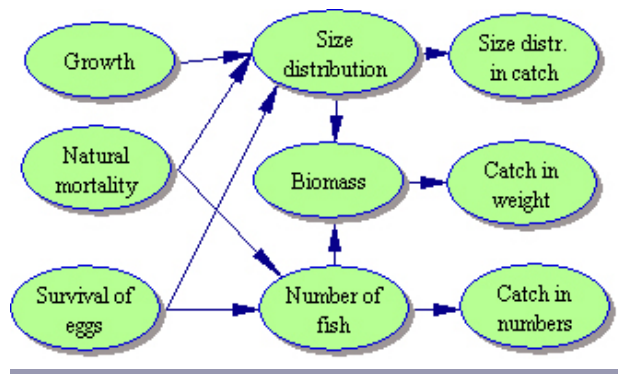
Fig. 1. The biological core